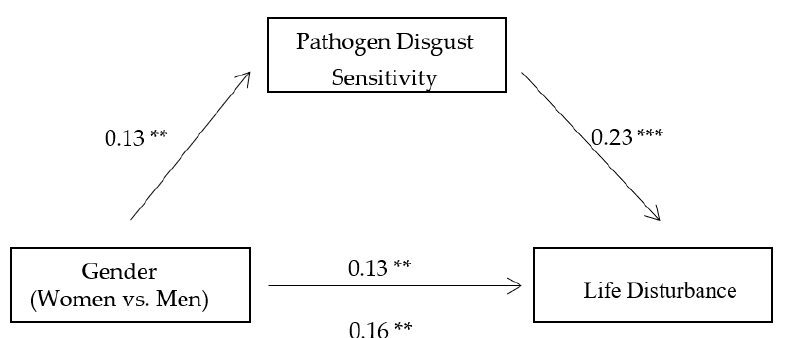
Figure 3. The mediating role of pathogen disgust sensitivity between gender and life disturbance. Note: Significance of standardized regression coefficients is indicated (** p < 0.01 and *** p < 0.001).